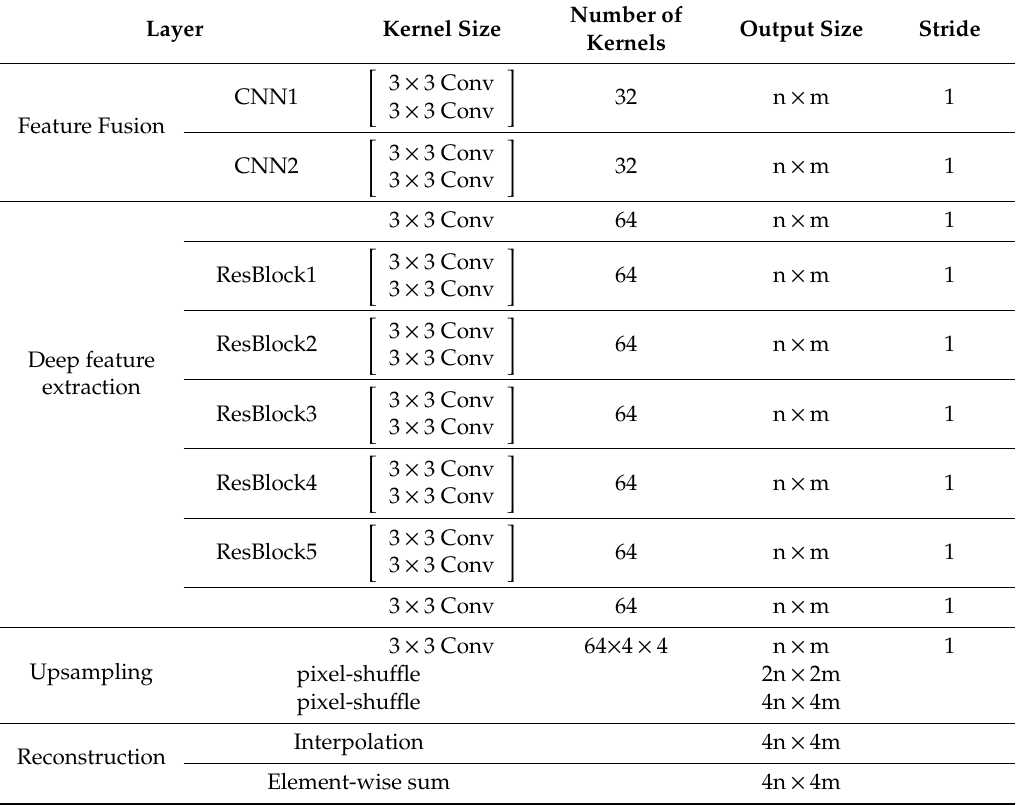
Table 2. The specific architecture of UDGN when the upscale factor is